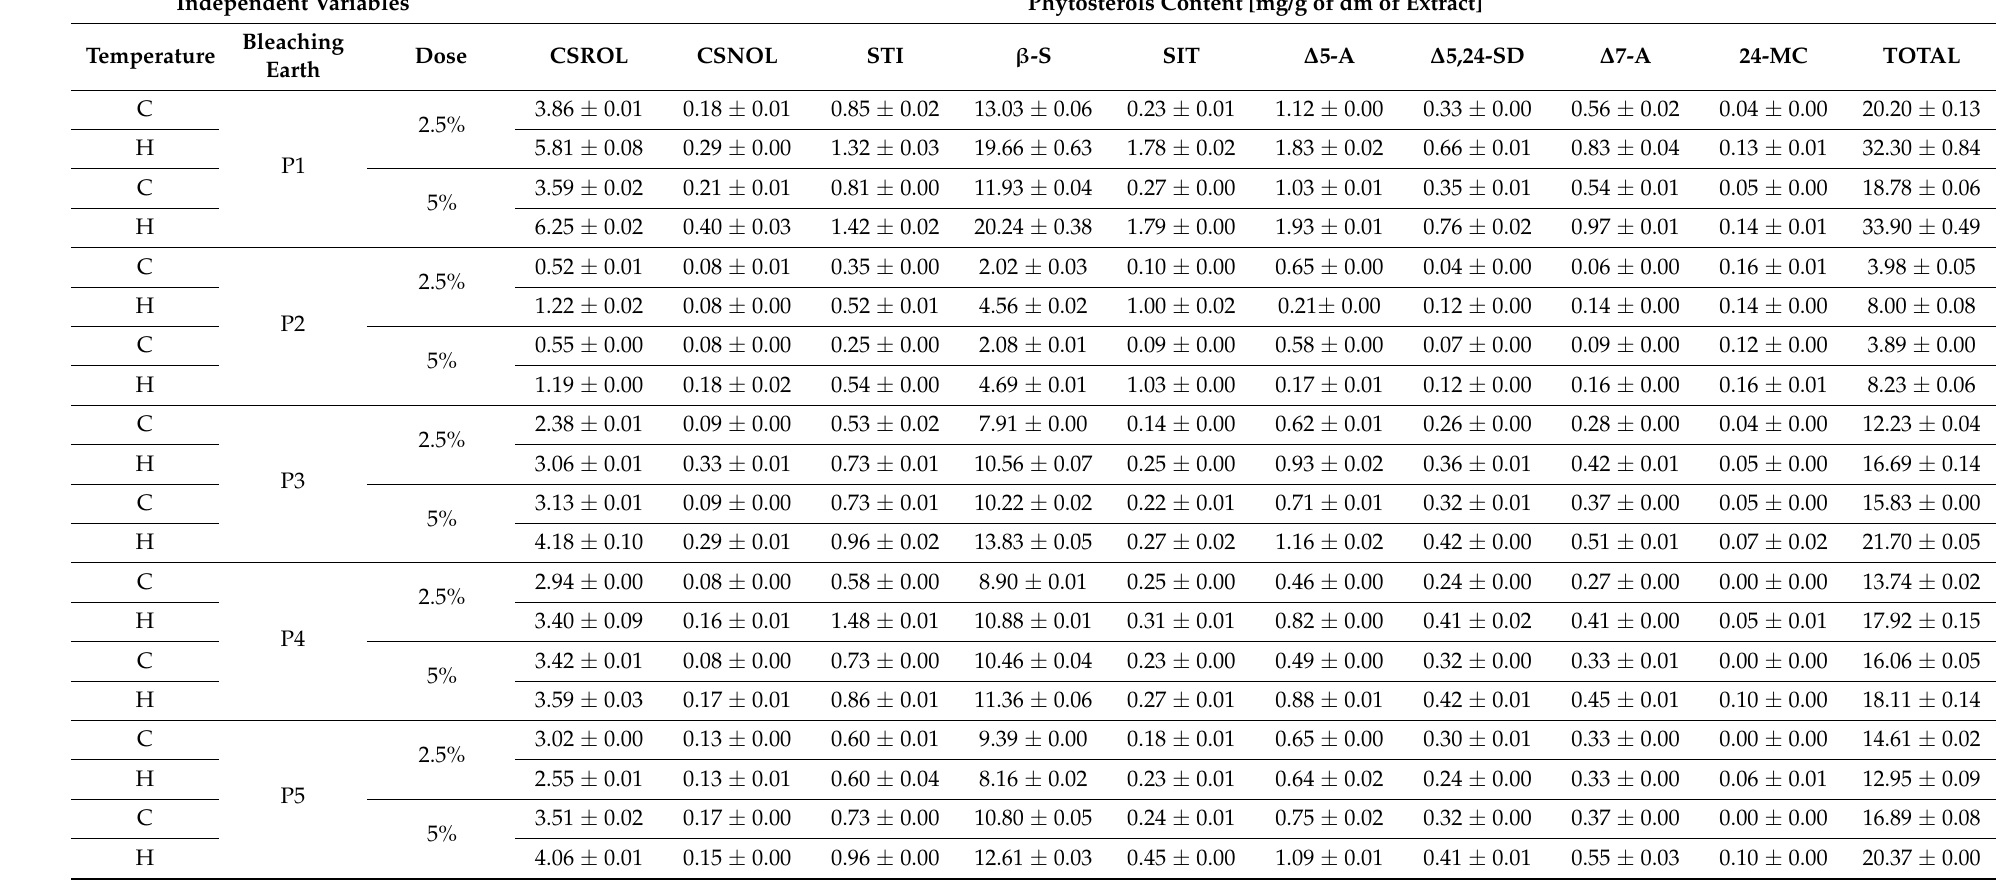
Table A3. The content of phytosterols in the poraffin extracts formed after washing bleaching earth with methanol bleaching earth after bleaching oil from the ‘Finola’ variety. Mean values based on n =